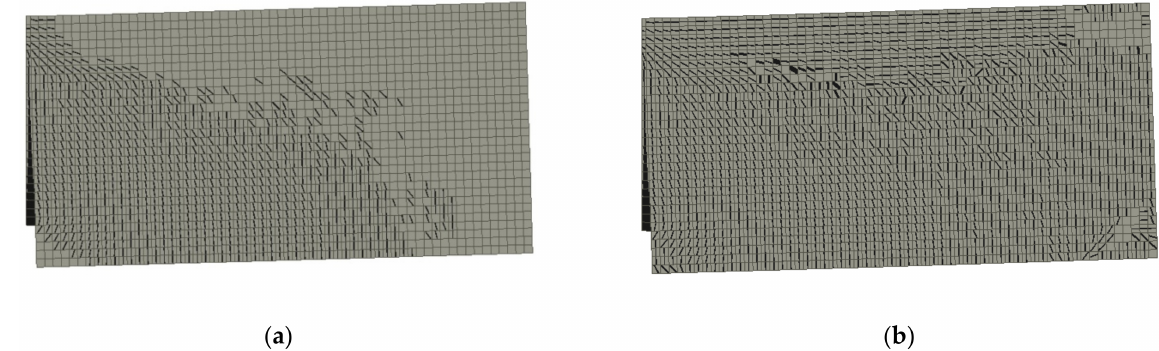
Figure 15. Crack propagation in all models for CMOD = 0.5 mm: ( a ) 0.5% and ( b ) 1.5%.